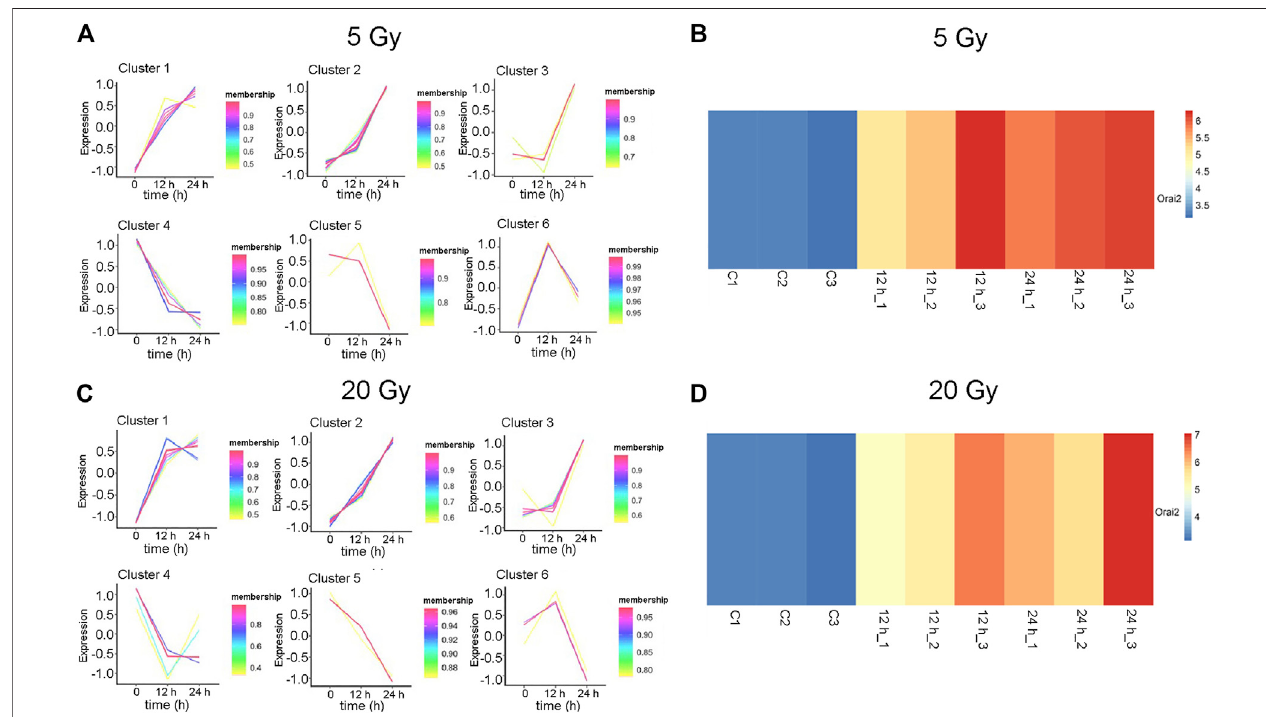
FIGURE 5 | Expression patterns of 40 differentially expressed genes (DEGs). (A – B) Six gene expression pattern diagrams were drawn based on the expression levels of 40 DEGs 12 and 24 h after brain microvascular endothelial cells were irradiated with a delivered x-ray dose of (A) 5 Gy or (B) 20 Gy. (C – D) Overview of Orai2